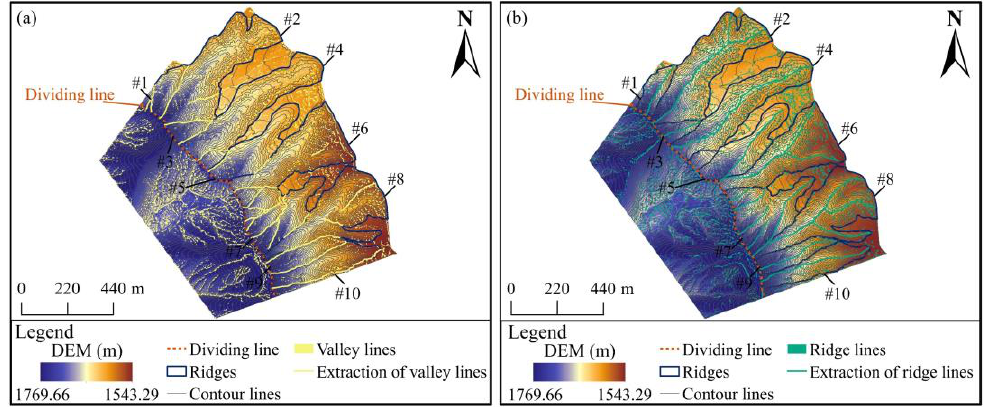
Figure 10. ( a ) The valley lines extraction results, and ( b ) the ridge lines extraction results.